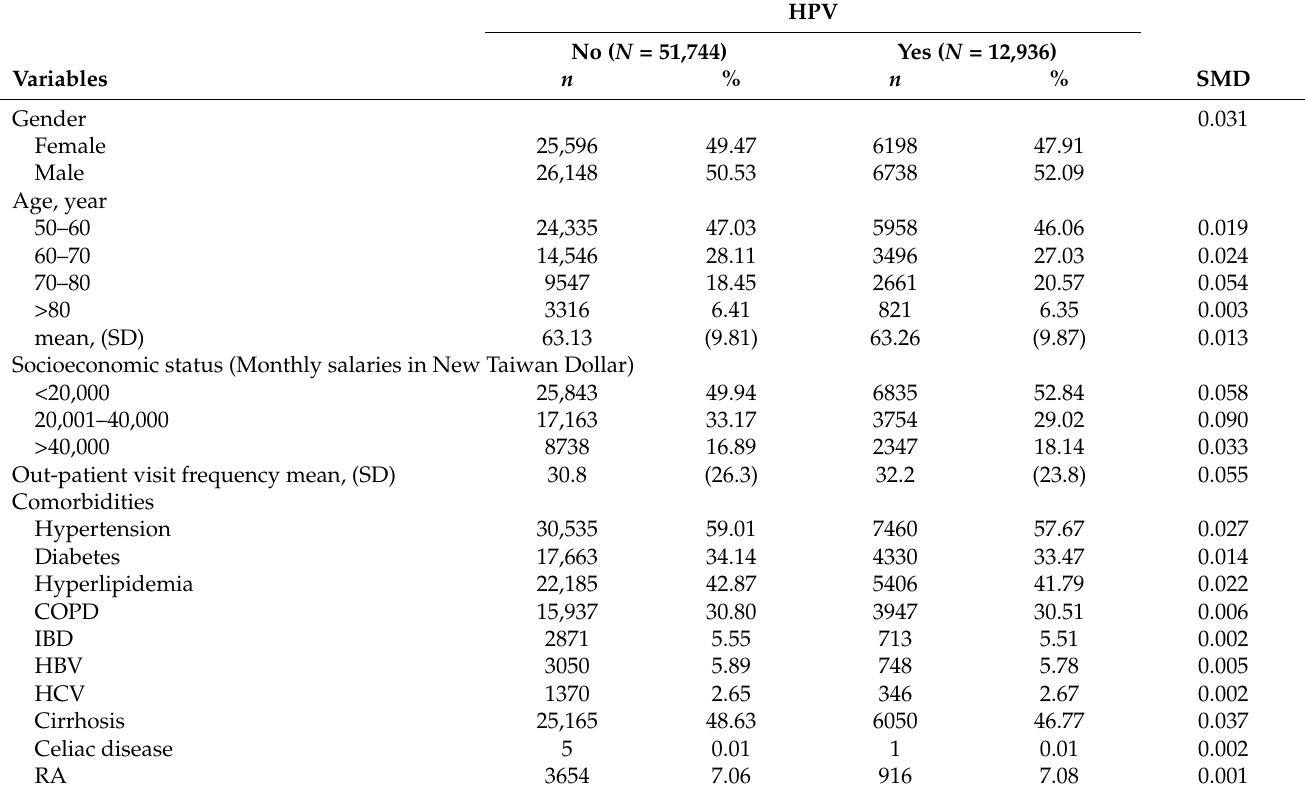
Table 1. Baseline characteristics in HPV-infected patients and non-HPV